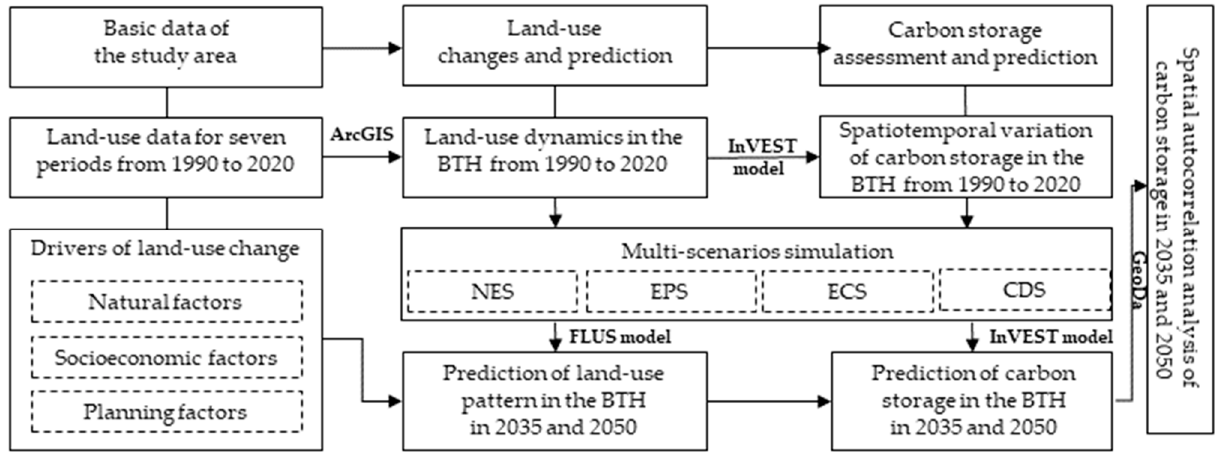
Figure 2. Research framework.